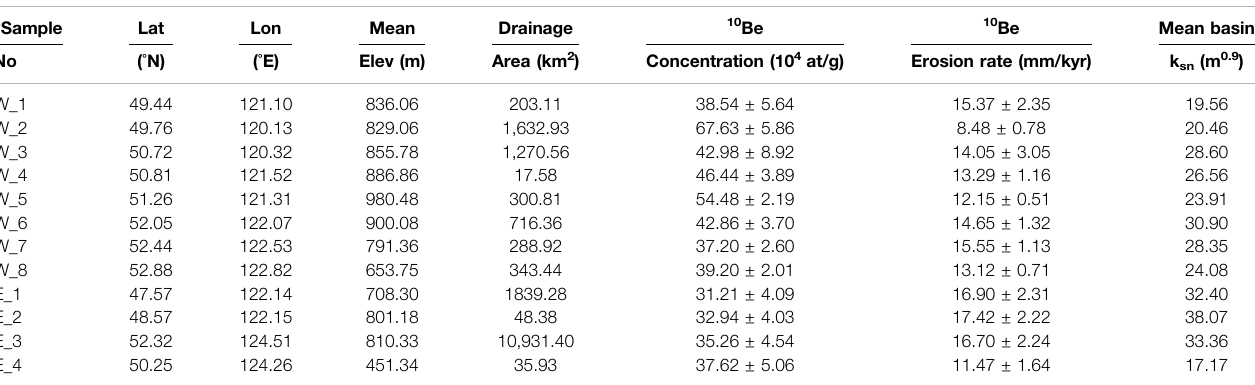
TABLE 1 | Sample locations and corresponding basin-wide erosion